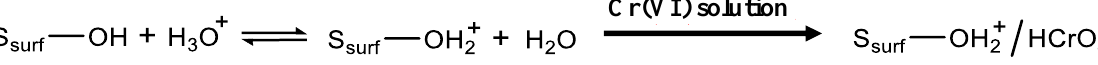
Figure 9. Absorption spectra of Cr(VI) adsorbed on silica-based xerogel at different initial concen- trations (mg/L) from 36.53 to 269.20 mg/L.